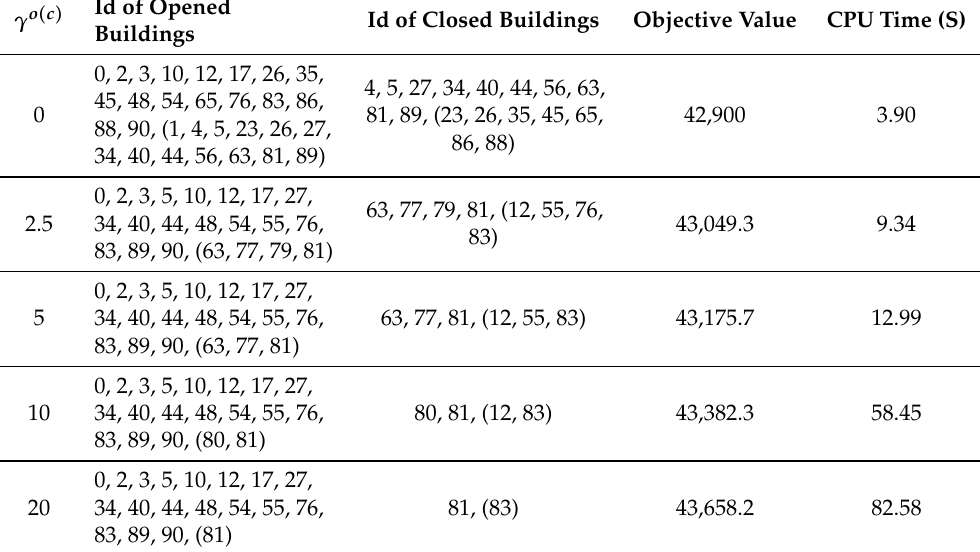
Table 14. Sensitivity Analysis on Cost Coefficients (together).